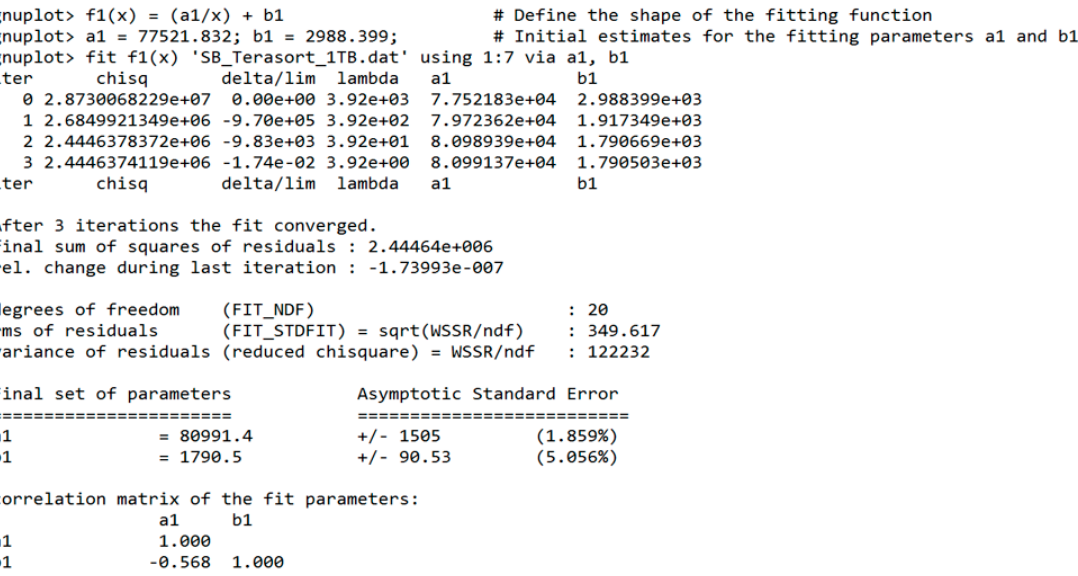
Figure 4. Fitting Spark-Bench Terasort preview data points for 1 TB to the function f ( x ) = ( a / x ) + b .